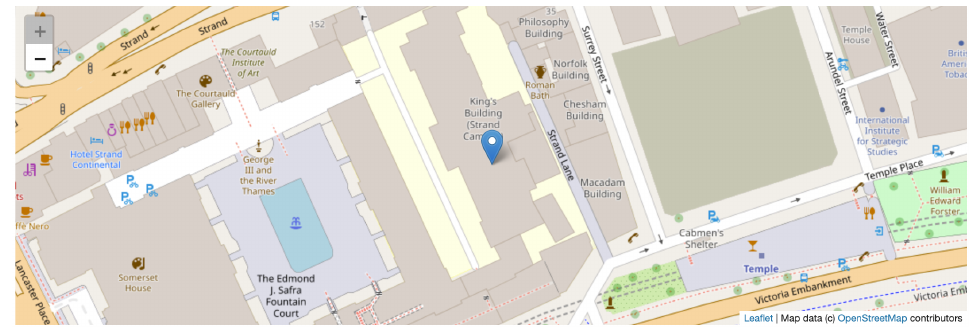
Figure 2: Output of code